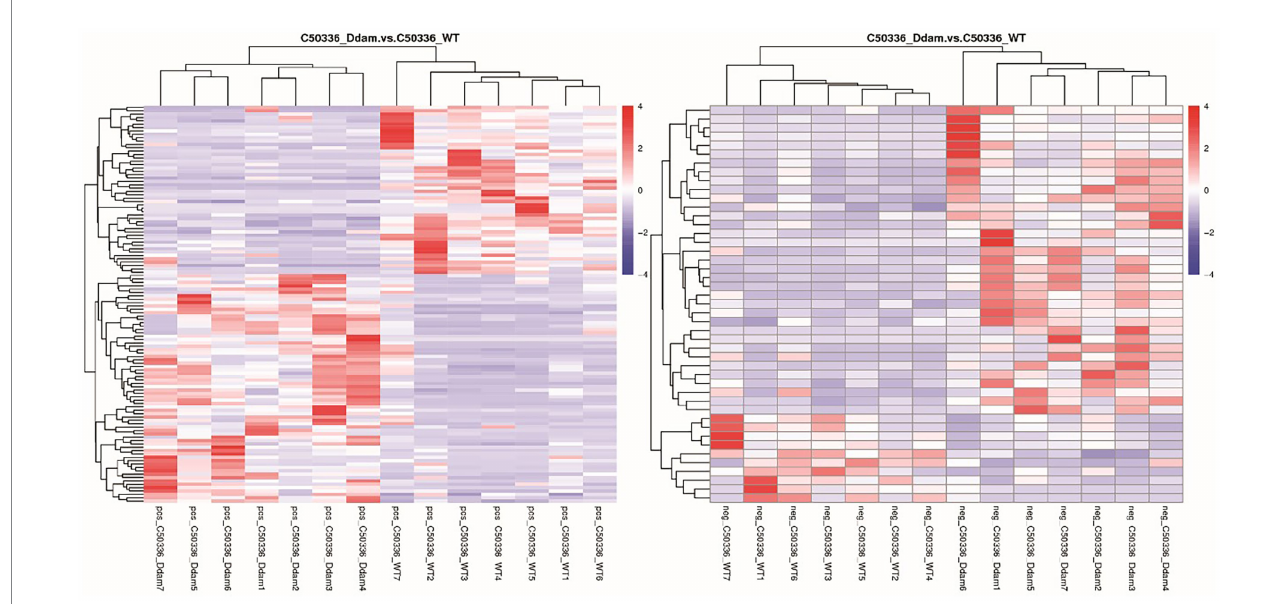
FIGURE 3 The dam gene of SE could affect certain specific metabolic pathways in J774A.1. (Left) Picture is positive ion mode, the (right) picture is negative ion mode. Longitudinal is the clustering of samples, and horizontally is the clustering of metabolites. Through horizontal comparison, the relationship between the metabolite content clustering between groups can be obtained.